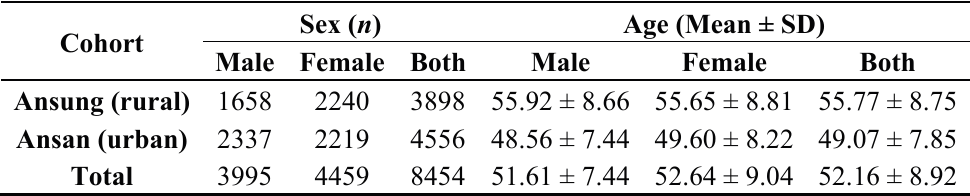
Table 3. Demographic characteristics of participants in the Korean